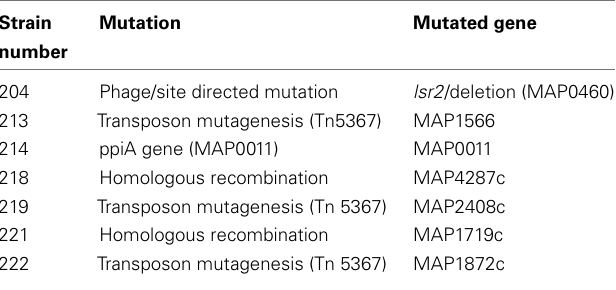
biological replicates. An # indicates significantly different from ATCC#19698 (ATCC)-infected macrophages at p < 0.05 while a *indicates significant difference from control, uninfected macrophages at p < 0.05.The nature of each mutation is presented in Table 2 , as described in the